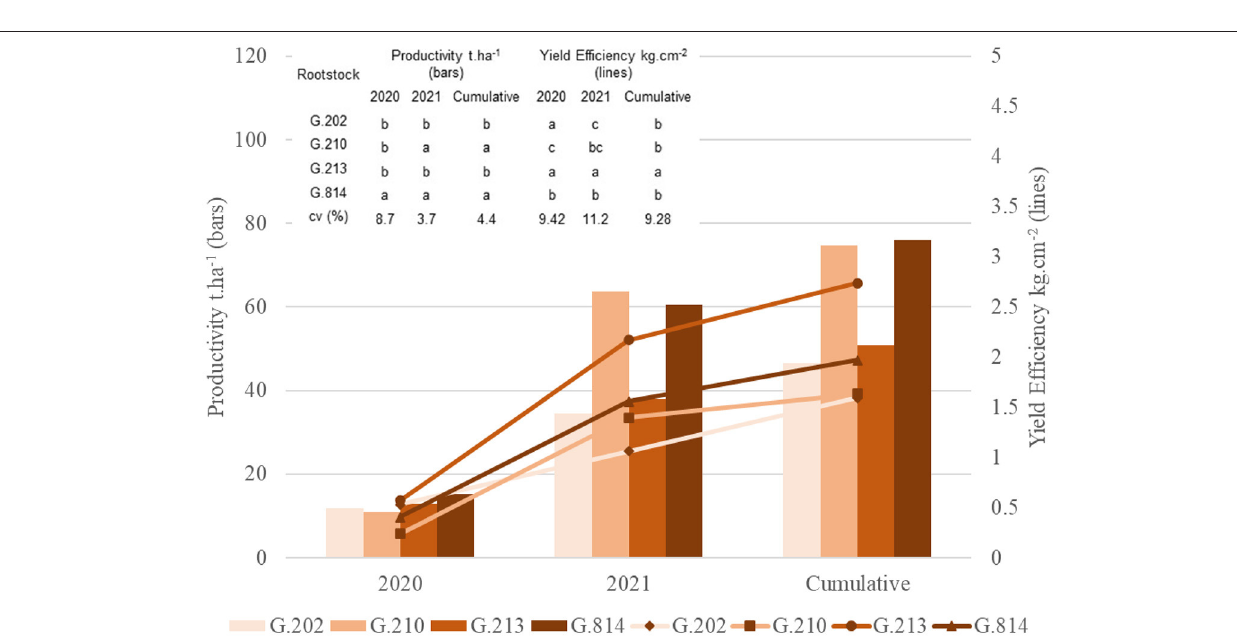
2 years was higher for the G.814 and G.210 rootstocks when compared to the G.202 and G.213